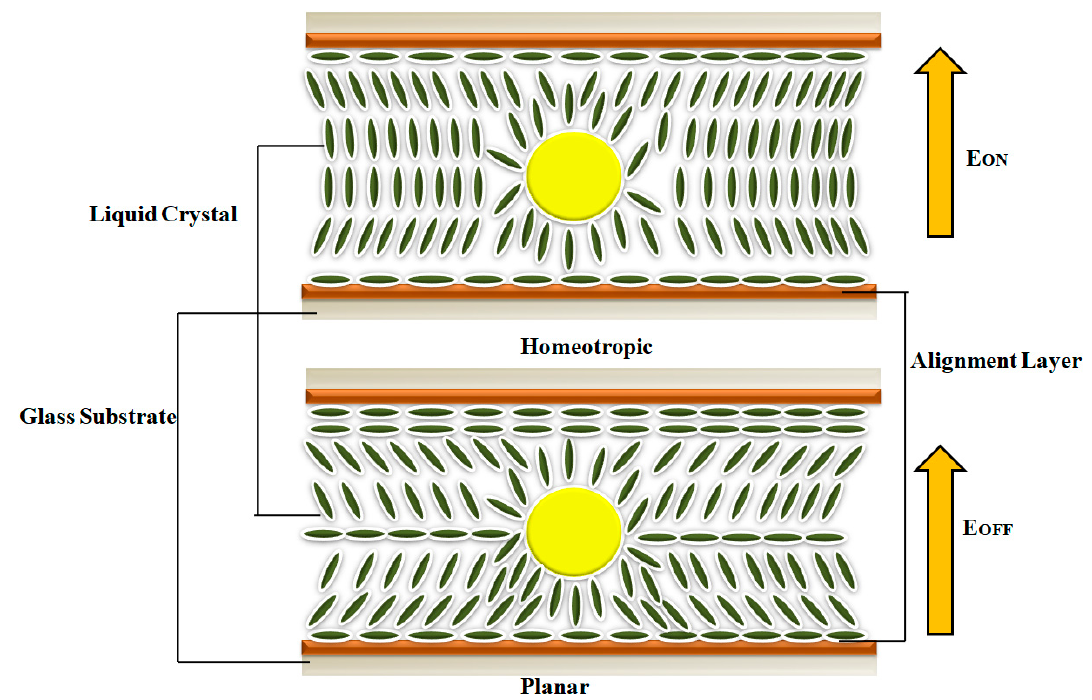
Figure 4. Schematic representation of electric field reorientation of liquid crystal molecules in QDs doped sample.